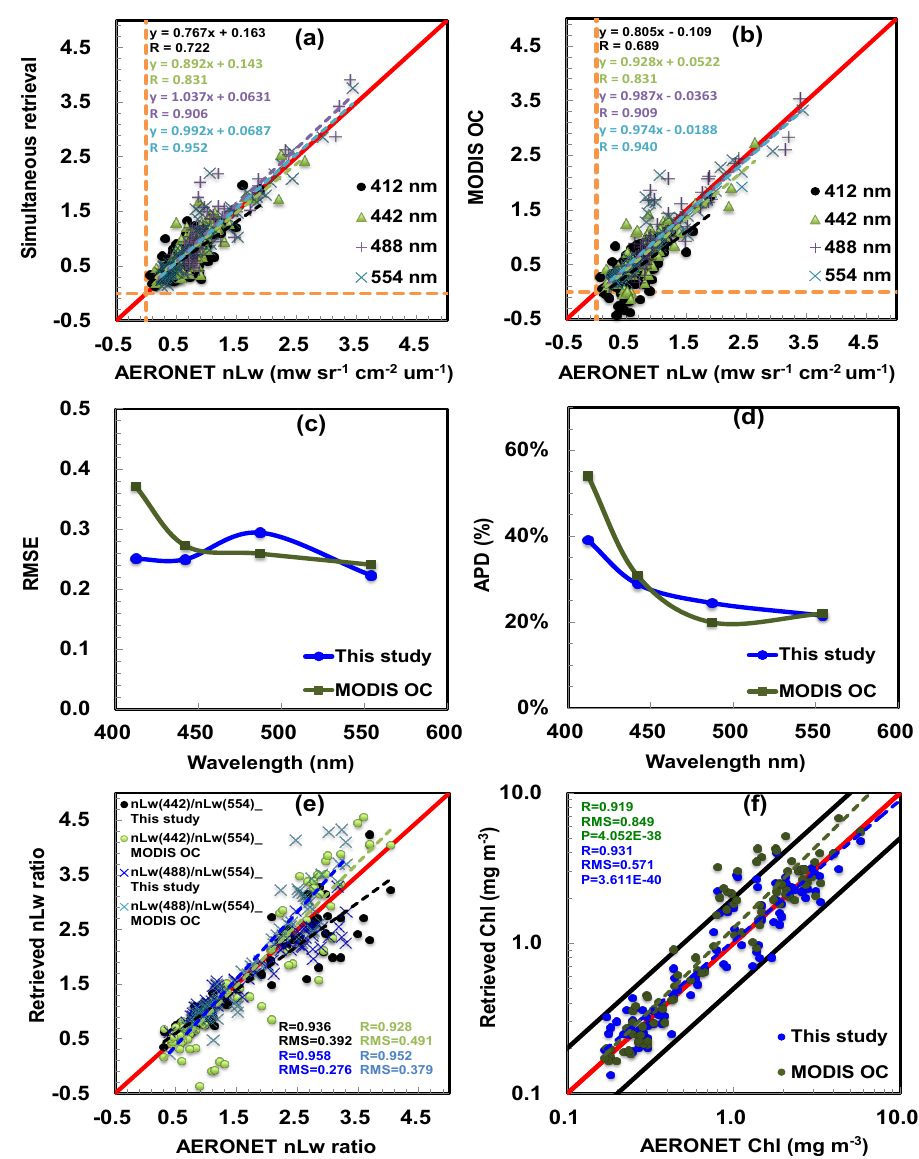
Figure 7. Comparison of jointly retrieved nL w at 412, 442, 488 and 554nm from the simultaneous retrieval algorithm (a) and MODIS OC products (b) using measurements out of sunglint with AERONET in situ observation. Statistical values of RMSE (c) , APD (d) , band ratios of nL w (442)/nL w (554) and nL w (488)/nL w (554) (e) and Chl (f) results retrieved by the two approaches compared with AERONET-OC products. The upper and lower black lines of panel (f) are 1 : 2 and 2 : 1, respectively. The dashed lines are denoted as regression lines, which correspond to the retrieved results with the same